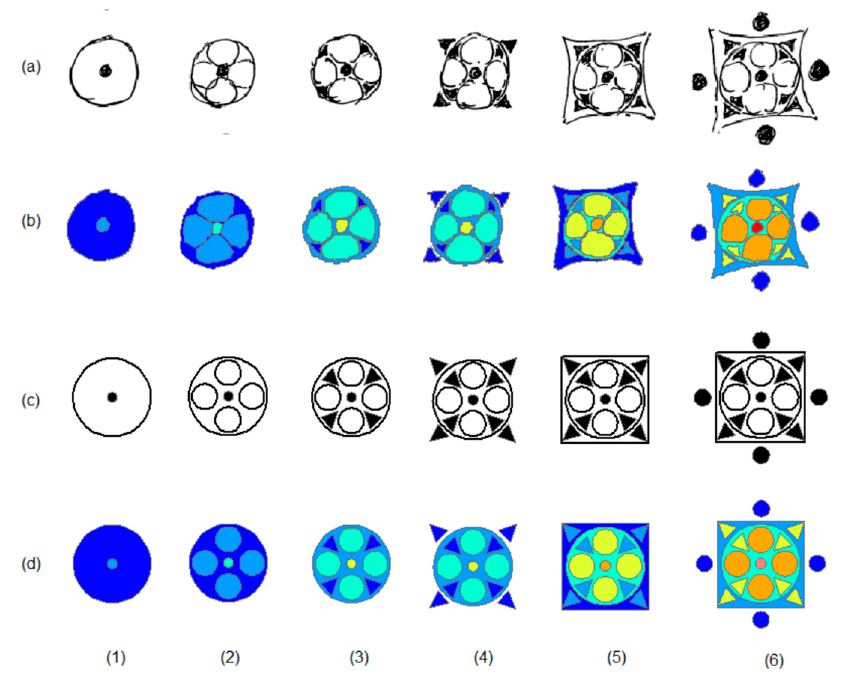
Figure 1. (Color online) A living (6a and 6b) versus a less-living structure (6c and 6d). Note: The living structure is evolved as a product of living process, while the less-living structure comes from a simple drawing. The living structure is well differentiated and well adapted, not only among those in the figure, but also among those in the ground, whereas the less-living structure looks like an assembly from pre-determined pieces, which are not well adapted to each other. For example, the four dots outside the square in 6c and 6d are less integrated into the whole than those in 6a and 6b. The coloring indicates the degree of wholeness, with blues showing the lowest, red showing the highest, and other colors in between the lowest and highest.)